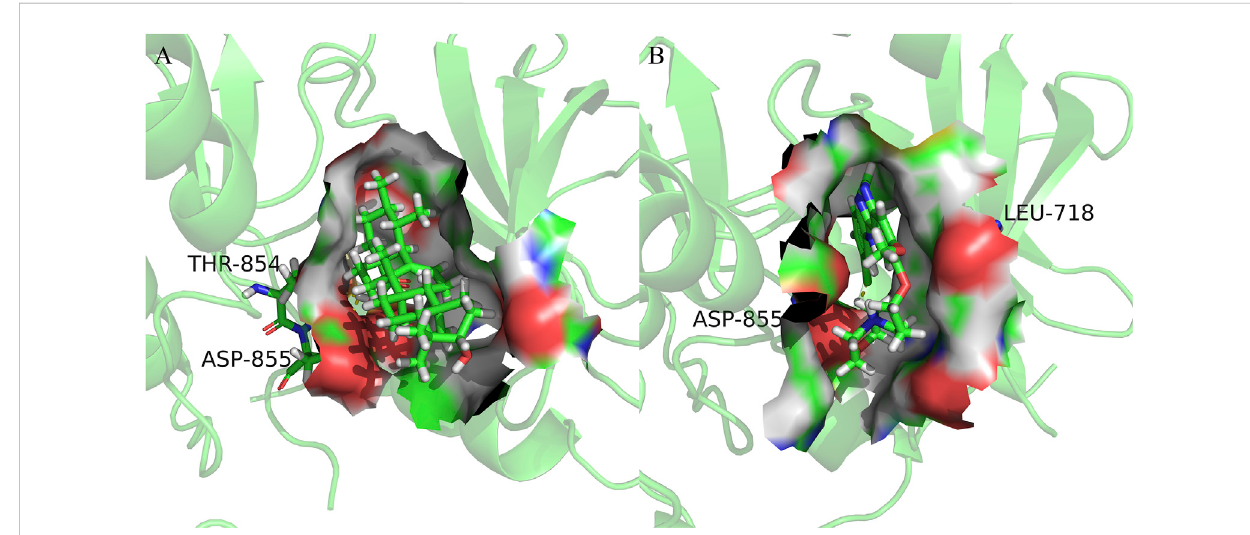
FIGURE 7 Cartoon representation of EGFR in complex with: (A) Ursolic acid; (B) Ge fi tinib. The binding site is shown as surface representation with the ligands shown as